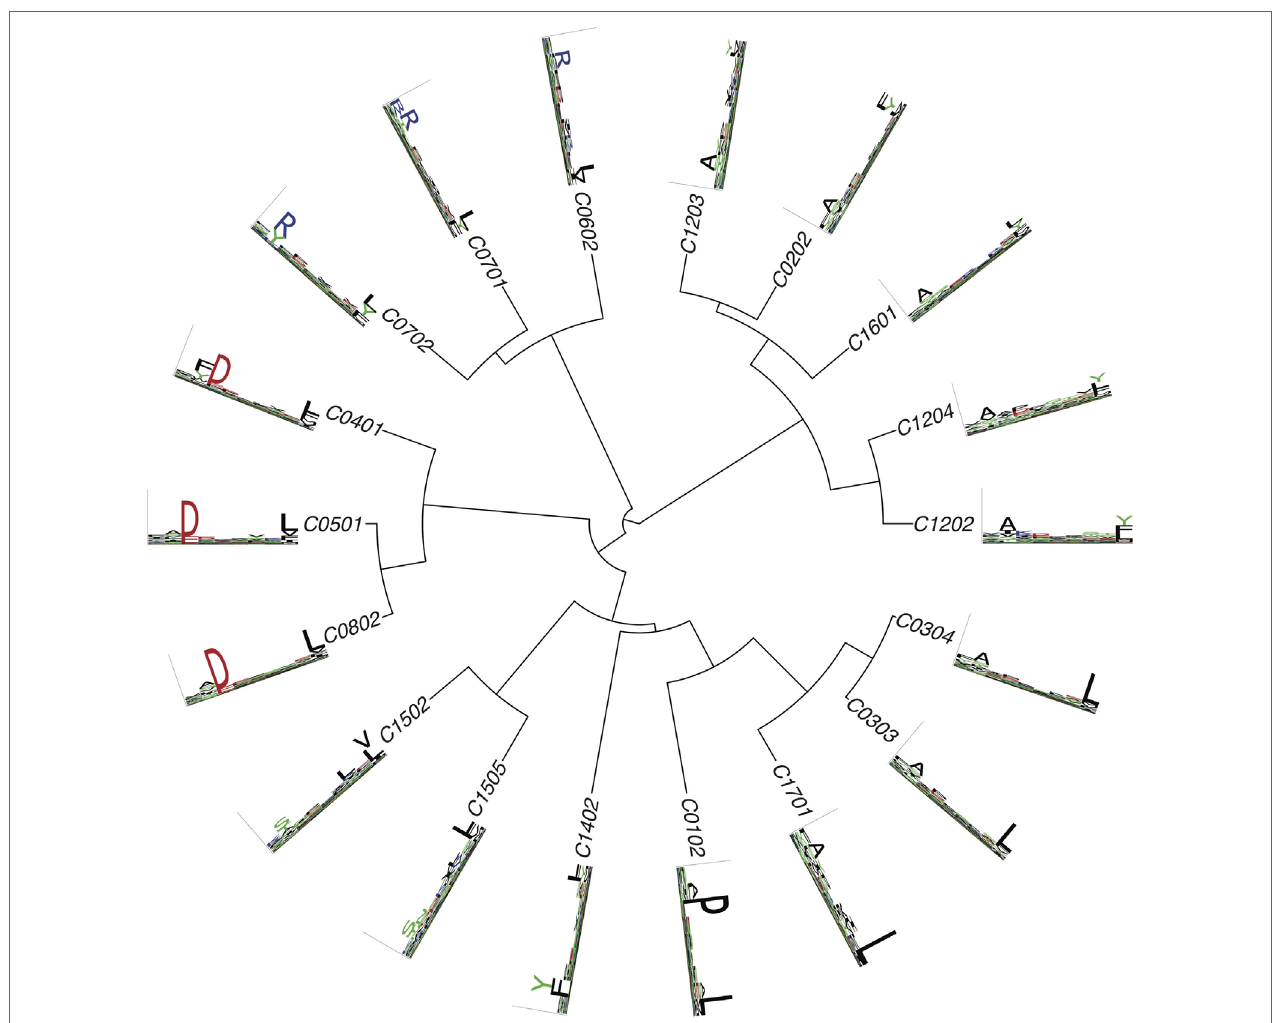
FiGURe 4 | Hierarchical clustering of HLA-C alleles based on their binding specificity. Only mass spectrometry data were used. Peptides from both single allele and deconvolved pooled HLA peptidomics samples were used (see Supplementary